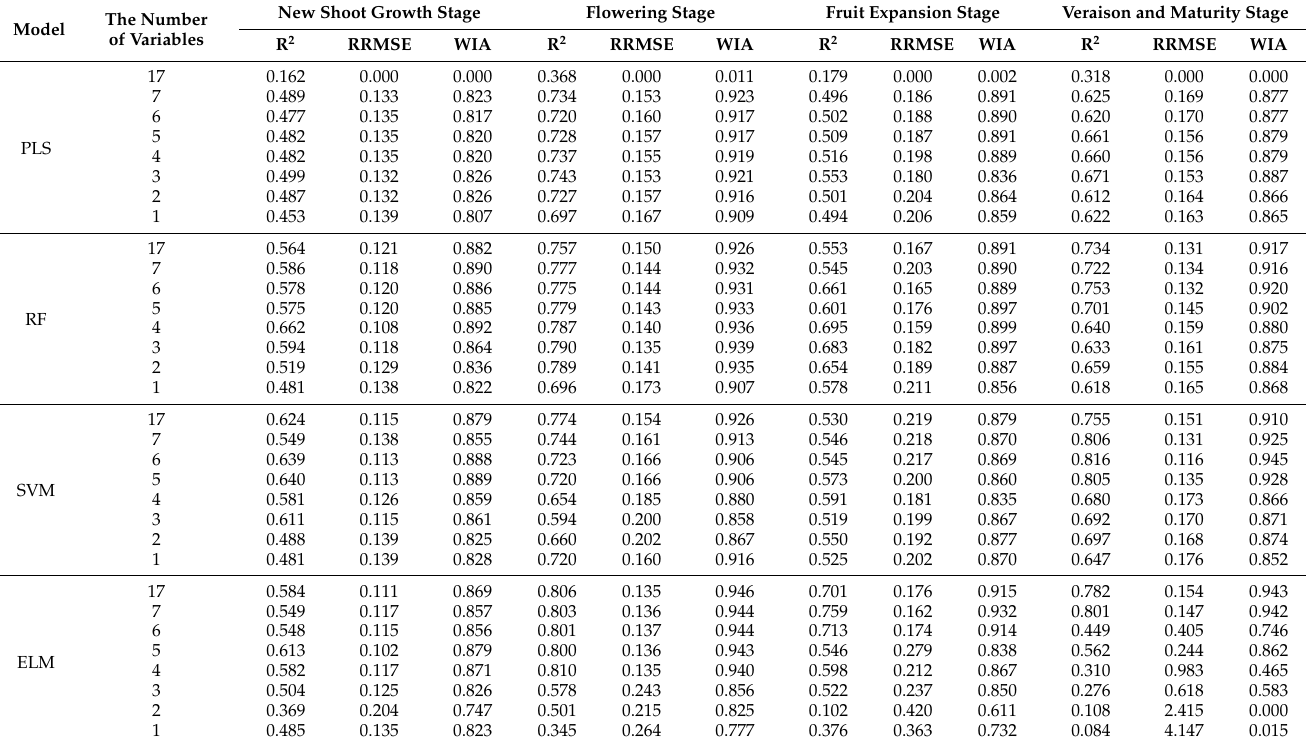
Table 5. Results analysis of LKC prediction model constructed based on different spectral